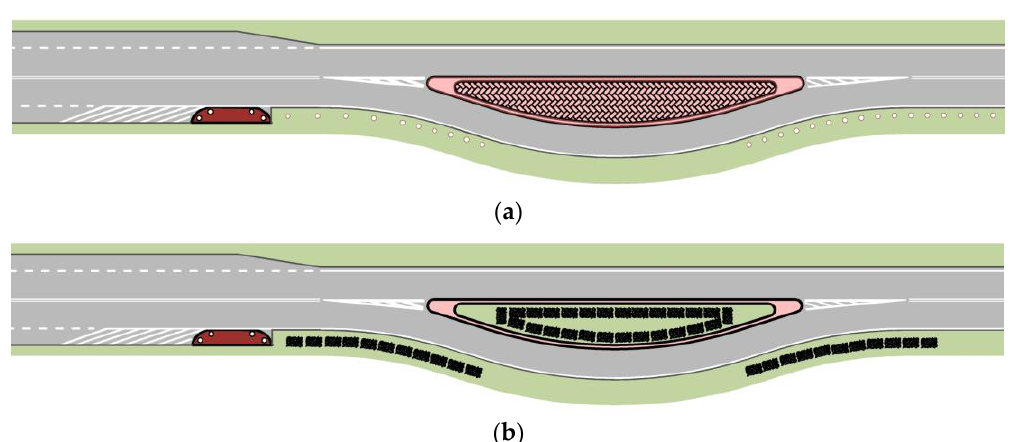
Figure 16. Chicane scheme, where the chicane is preceded by a bulb-out with removal of hard shoulders following the chicane: ( a ) with bollards; ( b ) with hedgerows. Source: own work of the authors.